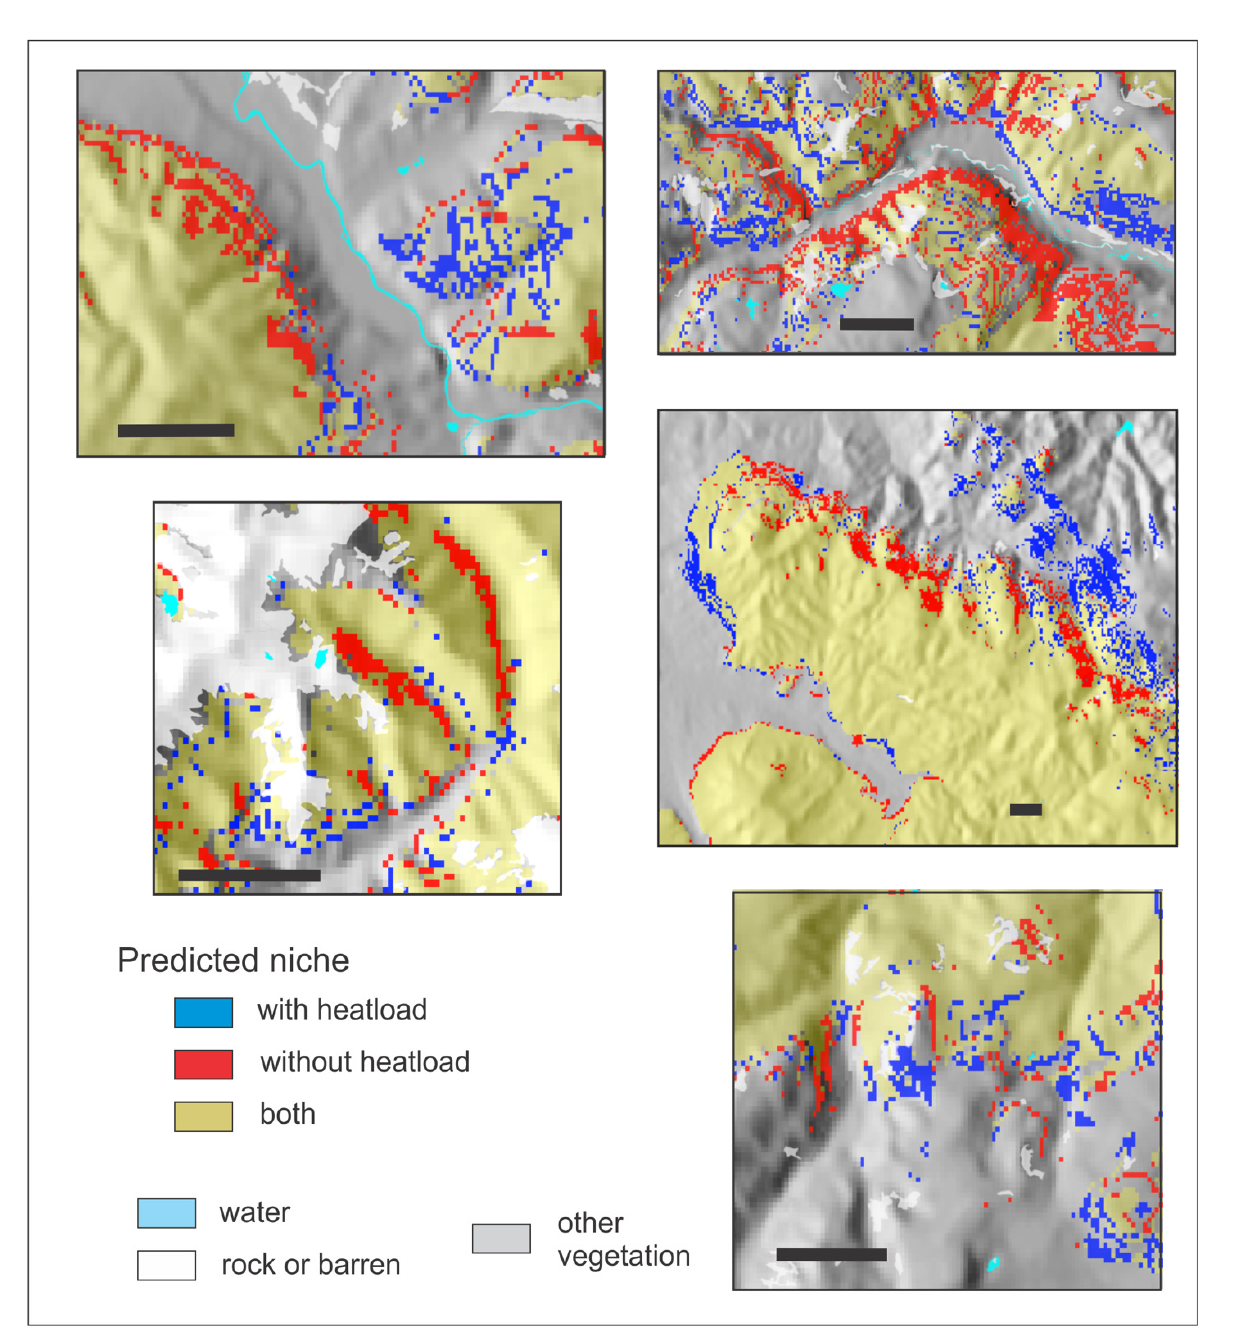
Figure A3. Reference period predicted niche of Pinus aristata from two random forests classification trees illustrating the effects of heatload as a predictor. Gold, niche predicted by both models; red, predicted by 11 climate variables; blue, predicted by the climate variables plus heatload. Scale bar in each panel is 2 km.